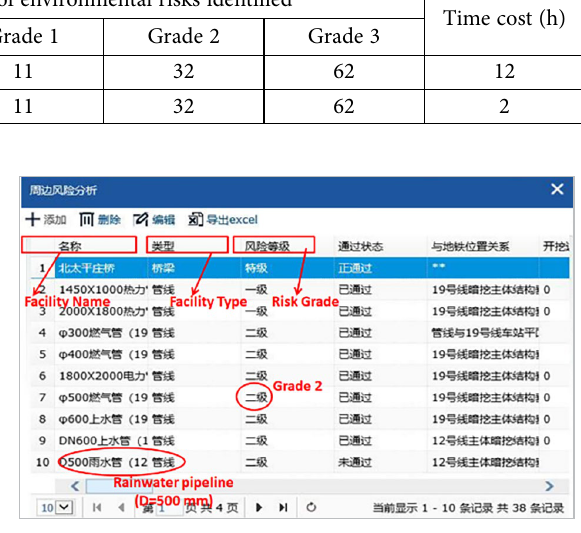
Figure 16. Environmental risk engineering list